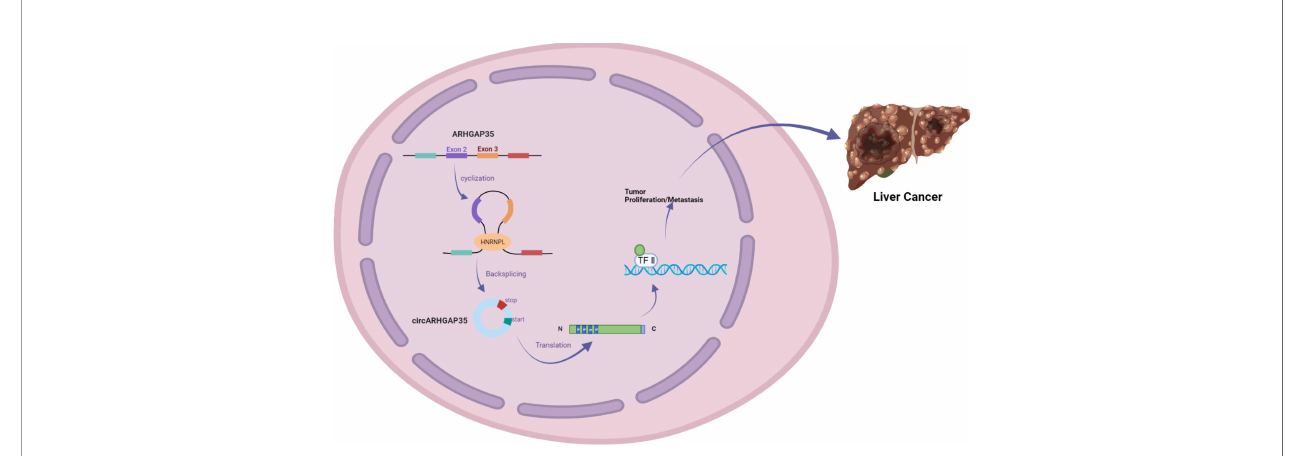
FIGURE 3 | circARHGAP35 is formed by back-splicing of exons 2 and 3 of the tumor suppressor gene ARHGAP35 (also known as P190-a), and the RNA-binding protein HNRNPL promotes circARHGAP35. circARHGAP35 encodes a truncated protein containing four FF domains and lacking the Rho-GAP domain. This truncated protein mainly resides in the nucleus and interacts with the TFII-I protein to promote the proliferation and metastasis of hepatoma